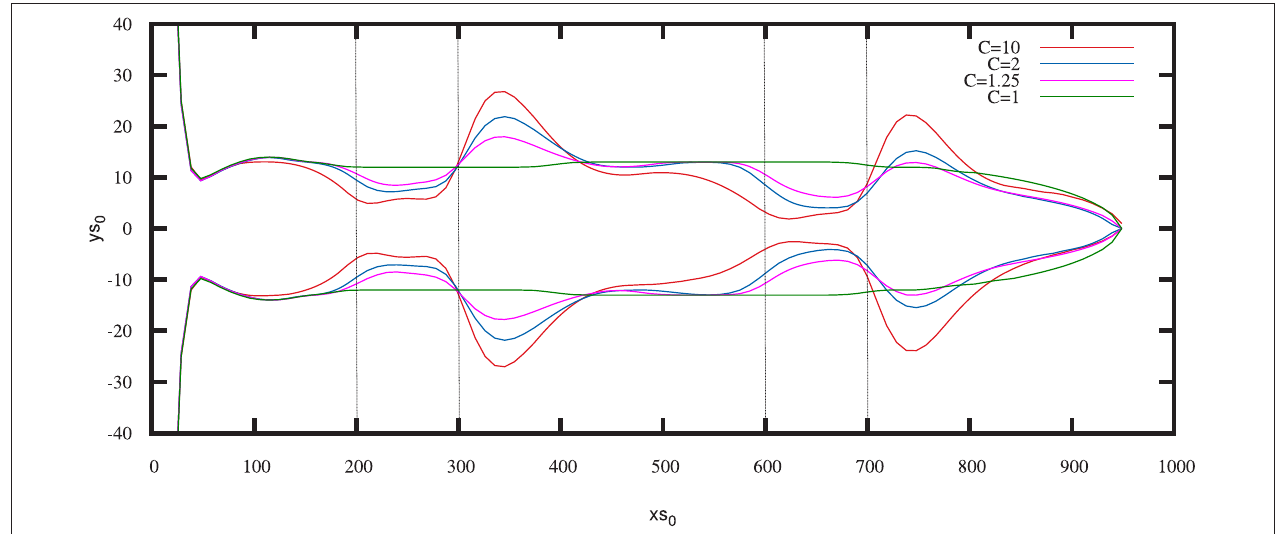
FIGURE 13 | Piping patterns for different contrasts of porosity (as marked) for Pe = 100 , Da = 0.1 . The aspect ratio of the plot has been altered to better visualize details.